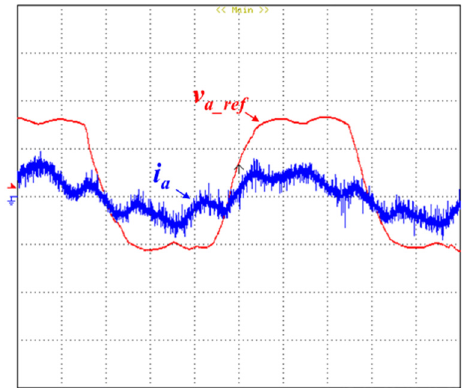
Figure 29. Reference signal and current in phase a when the electric machine operates with a 9 Nm mechanical load (current: 50 A/div; voltage: 5 V/div; time: 5 ms/div).